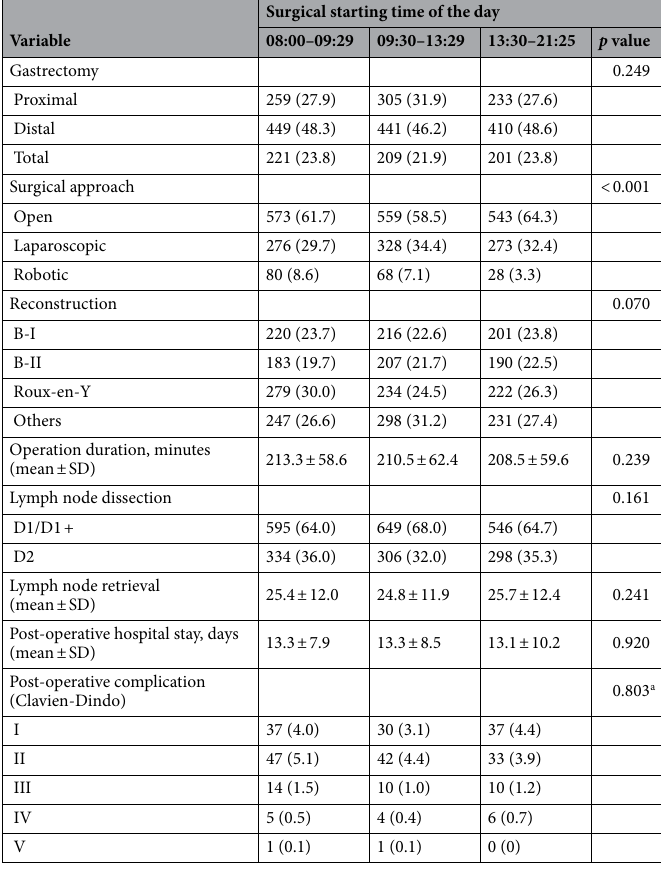
Table 2. Surgical and postoperative variables among 2728 patients who underwent gastrectomy for gastric cancer, number (%). SD standard deviation. a Fisher’s exact